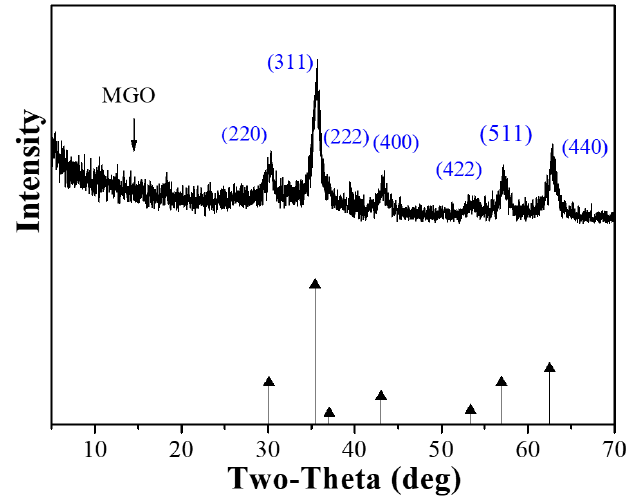
Figure 2. XRD patterns of MGO.